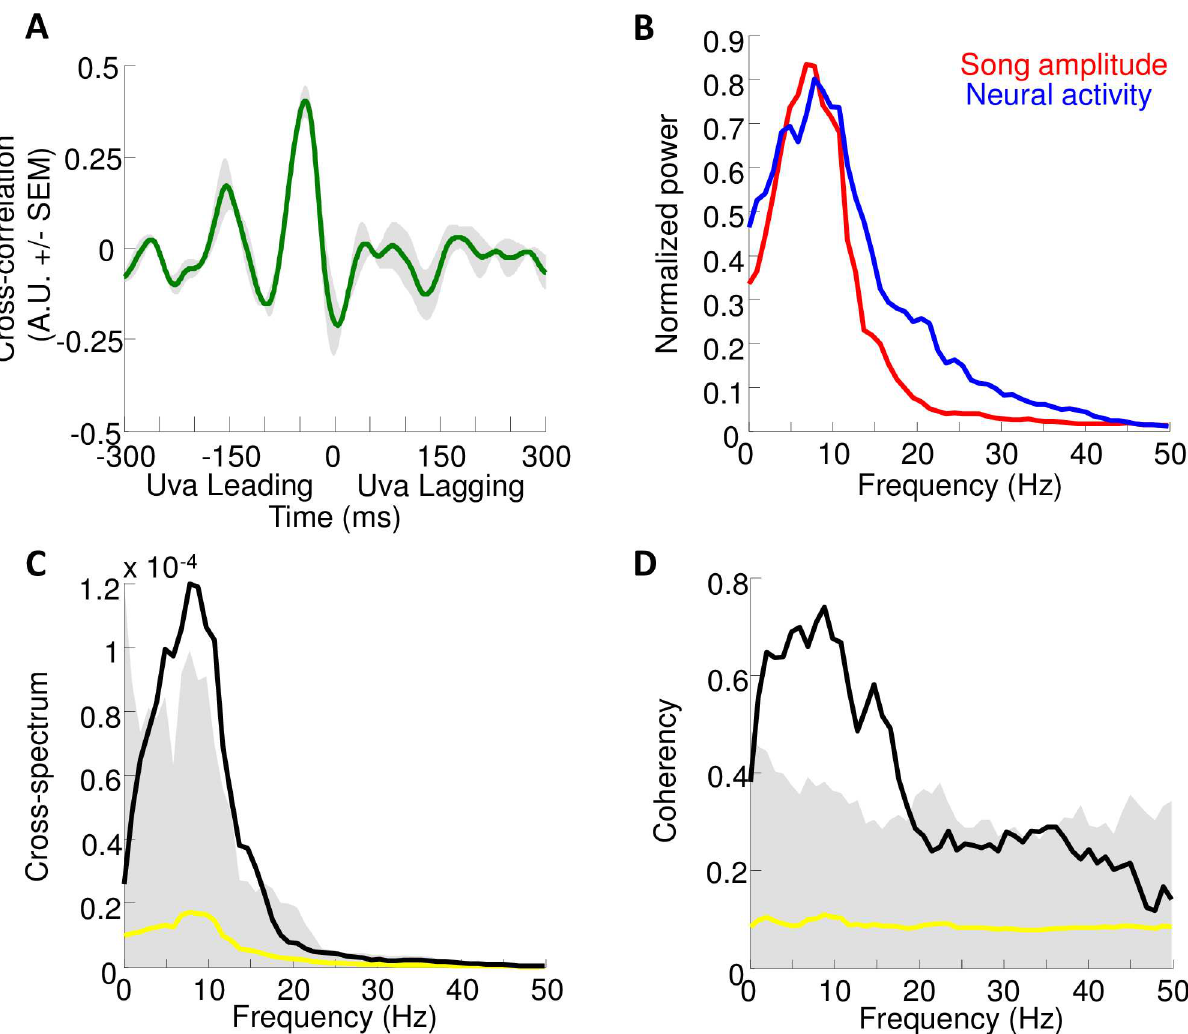
Fig 7. Quantification of rhythmic activity in Uva. (A) Cross-correlation function betweenUva activity and soundamplitudeaveraged across 5 birds (green: mean cross-correlation, shadedregion: SEM; peak correlation= 0.40 ± 0.04,mean lag at peak correlation= 42 ± 6ms). (B) normalizedpower spectra of the song amplitudes(red) and Uva multiunitactivity (blue), averagedacross n = 5 birds. A broad peak in the power spectrum is seen in both the song amplitudeand neuraldata, centered ~10Hz. (C) Cross-spectrum betweenUva activity and sound amplitudeaveraged across n = 5 birds (black: mean, yellow: null cross-spectrum, shaded region:95% percentilecorrected for multiple testing) (D) Coherency between Uva activity and sound amplitudeaveragedacross n = 5 birds (black: mean, yellow: null cross-spectrum, shadedregion: 95% percentile corrected for multipletesting). Note a large, significantpeak is observedin both the cross-spectrum and the coherence at ~10Hz (F peak = 8.8Hz, C peak = 0.75, p < 0.01,phase= -0.77 π ).